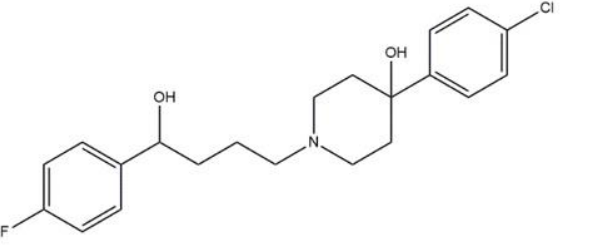
Figure 1. Haloperidol metabolite II with K i values for σ receptors.